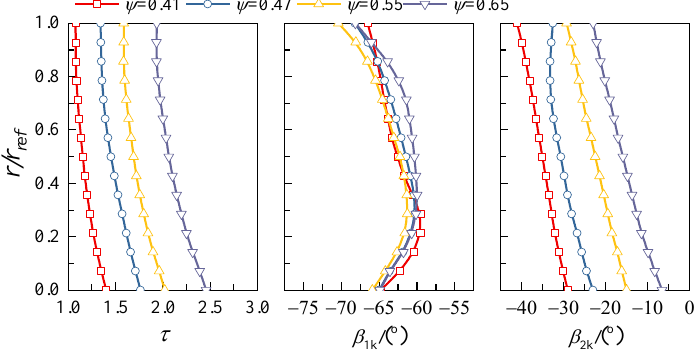
Figure 9. Comparison of design parameters for the four compressor stages: rotor.